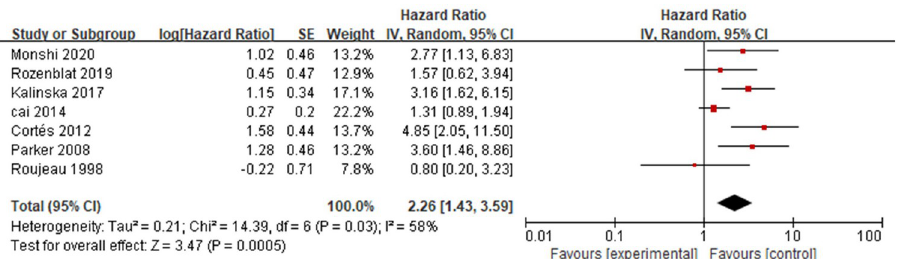
Fig 12. Forest plot of the association between dementia and bullous pemphigoid